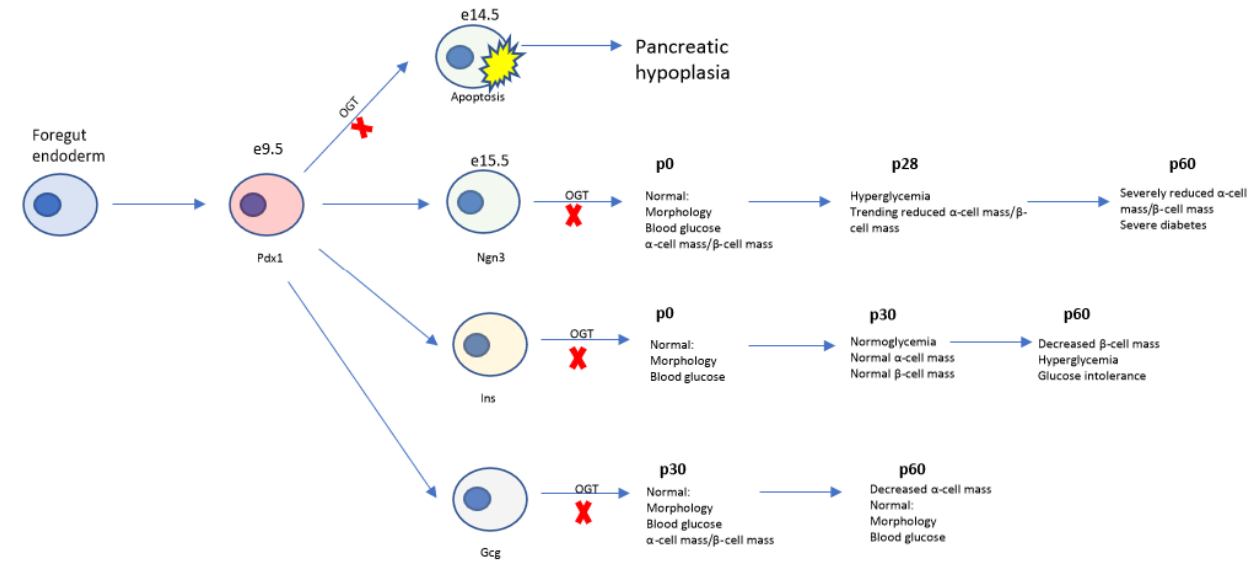
Figure 5. Summary of Ogt loss at various timepoints in pancreas development. Pancreas development begins in the foregut endoderm. A pool of Pdx1 + pancreatic progenitor cells give rise to both the endocrine and exocrine pancres. Deletion of Ogt at the pancreatic progenitor stage leads to pancreatic hypoplasia, in contrast to other models in which Ogt is deleted later in development.